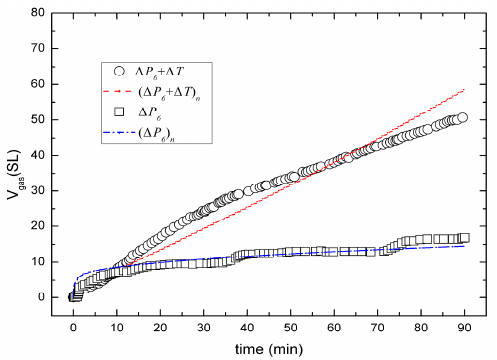
Figure 2. Comparison of the cumulative gas production obtained from the simulation results and the experimental data [17].